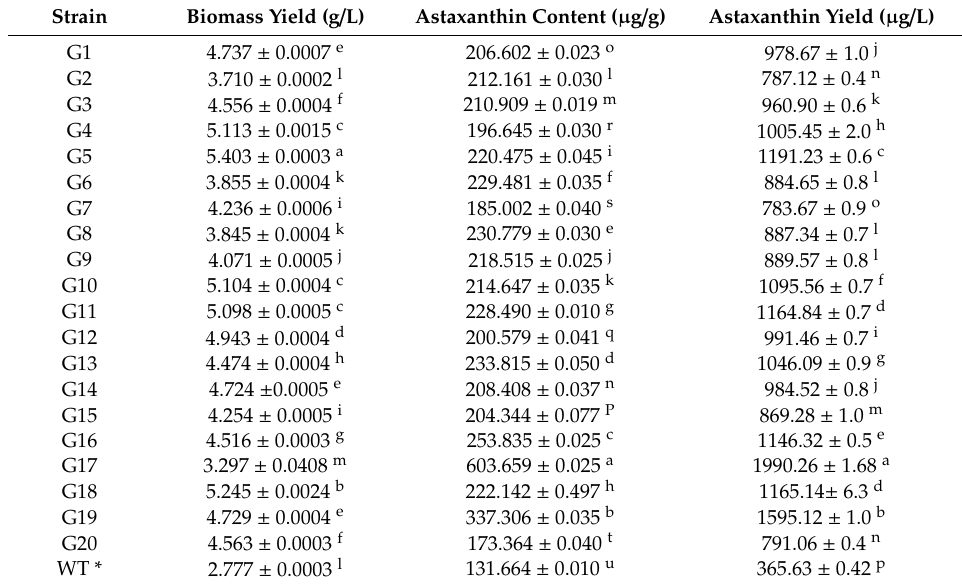
Figure 2. Effect of 60 Co-gamma irradiation dose on the survival rate of wild-type R. toruloides . Data are mean ± SD of three replicates. Table 3. Biomass and astaxanthin production by gamma-induced mutants.